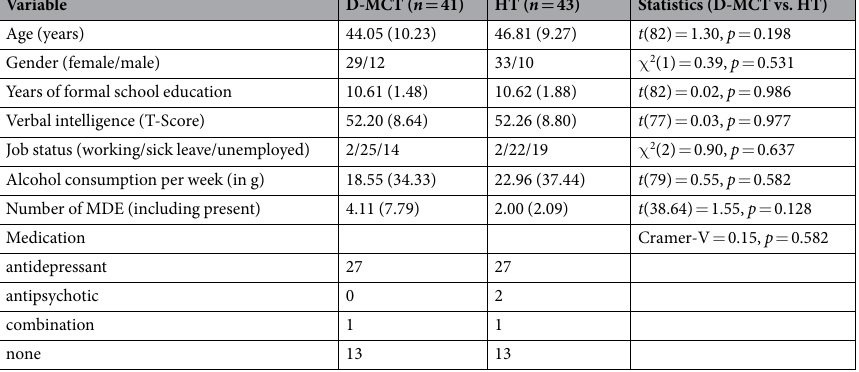
Table 1. Demographics: Frequencies, Means, and Standard Deviations (in Brackets). Note MDE = major depressive